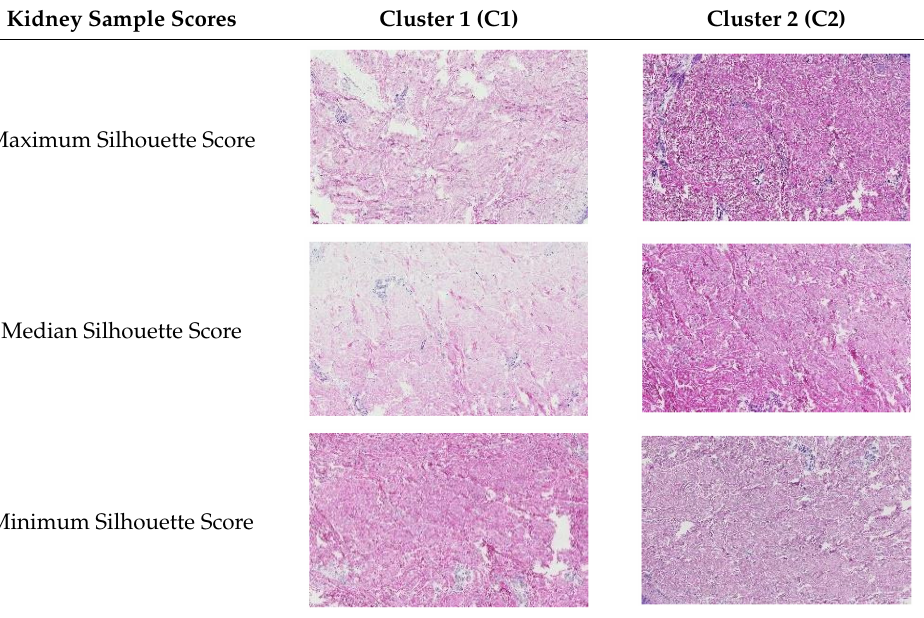
Table 4. Visualized skin samples for both found clusters with rank positions from each cluster’s silhouette scores.